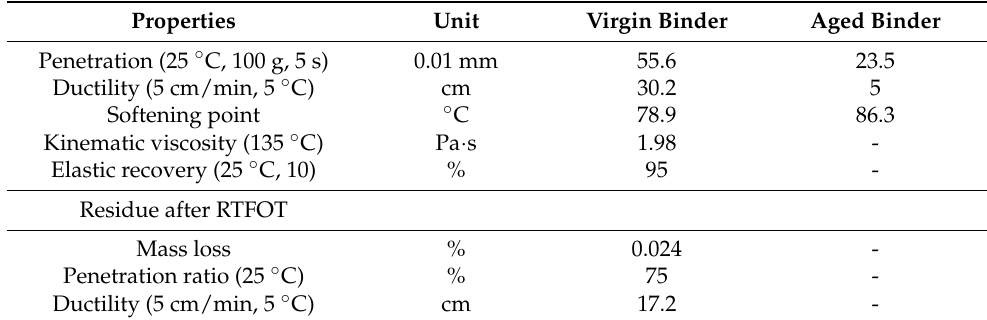
Figure 1. Extraction process of aged binder from RAP. Table 1. Fundamental properties of asphalt binders.